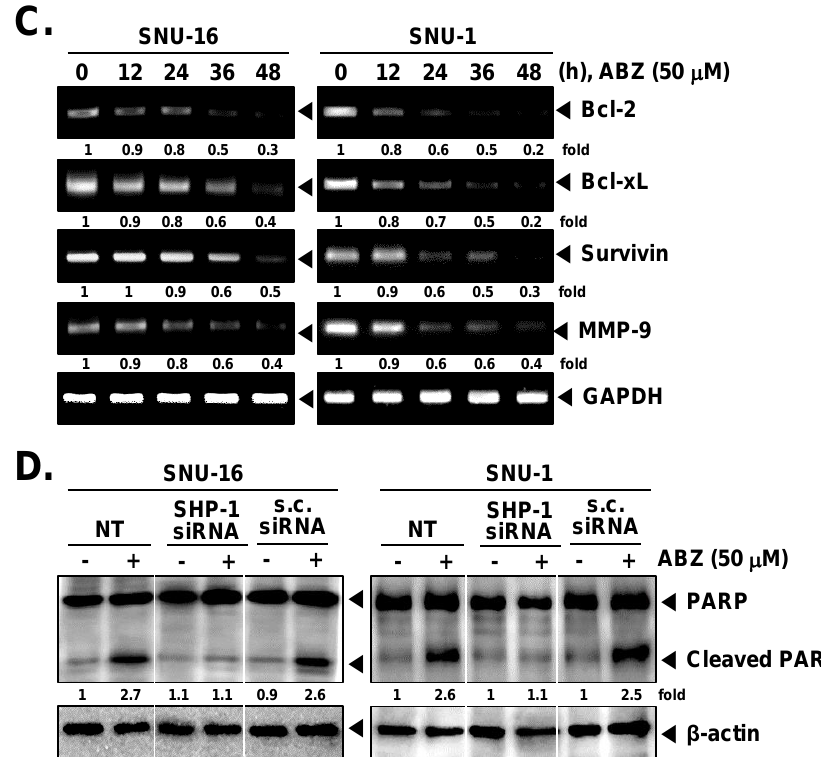
Figure 4. ABZ promotes activation of caspase-3 and PARP cleavage. ( A , B ) SNU-16 and SNU-1 cells were treated with ABZ 50 µ M for (0, 12, 24, 36, 48 h) and levels of various proteins were examined by western blot analysis. ( C ) Cells were treated as described above in panel ( A , B ), total RNA was extracted and examined for expression of Bcl-2, Bcl-xL, Survivin, and MMP-9 by RT-PCR. ( D ) Cells were transfected as described in Figure 2F and the western blotting for PARP was performed.